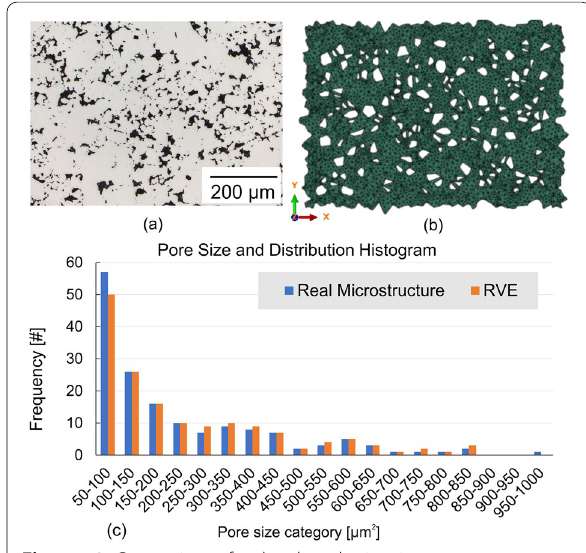
Figure 12 Comparison of real and synthetic microstructures: a real microstructure of Astaloy 85 Mo (pores are shown in black), b synthetic RVE based on statistical analysis of the real microstructure, c histogram plot comparing the pore size and distribution real microstructure and synthetic RVE